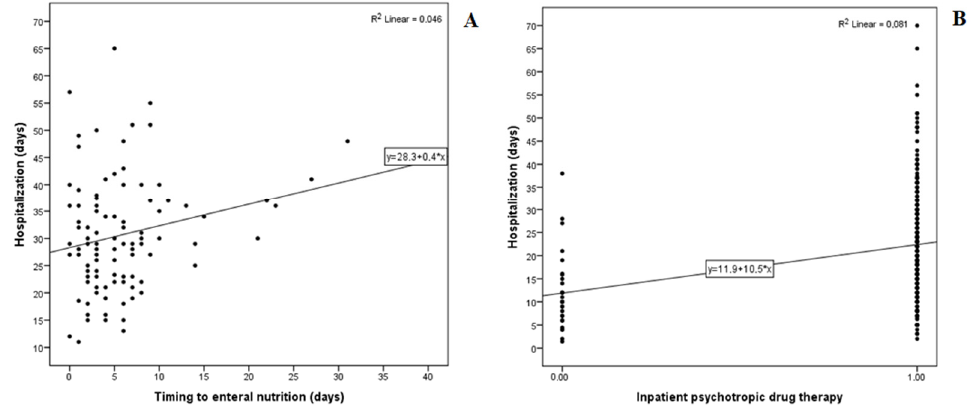
Figure 3. Effect of timing of NGF ( A ) and the administration of IPDT ( B ) on days of hospitalisation.